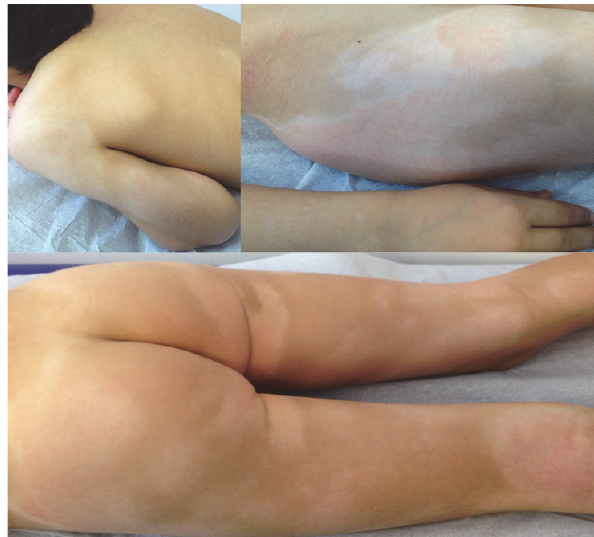
Figure 1: Patient presentation: generalized hypopigmented patches with central lacy erythema.